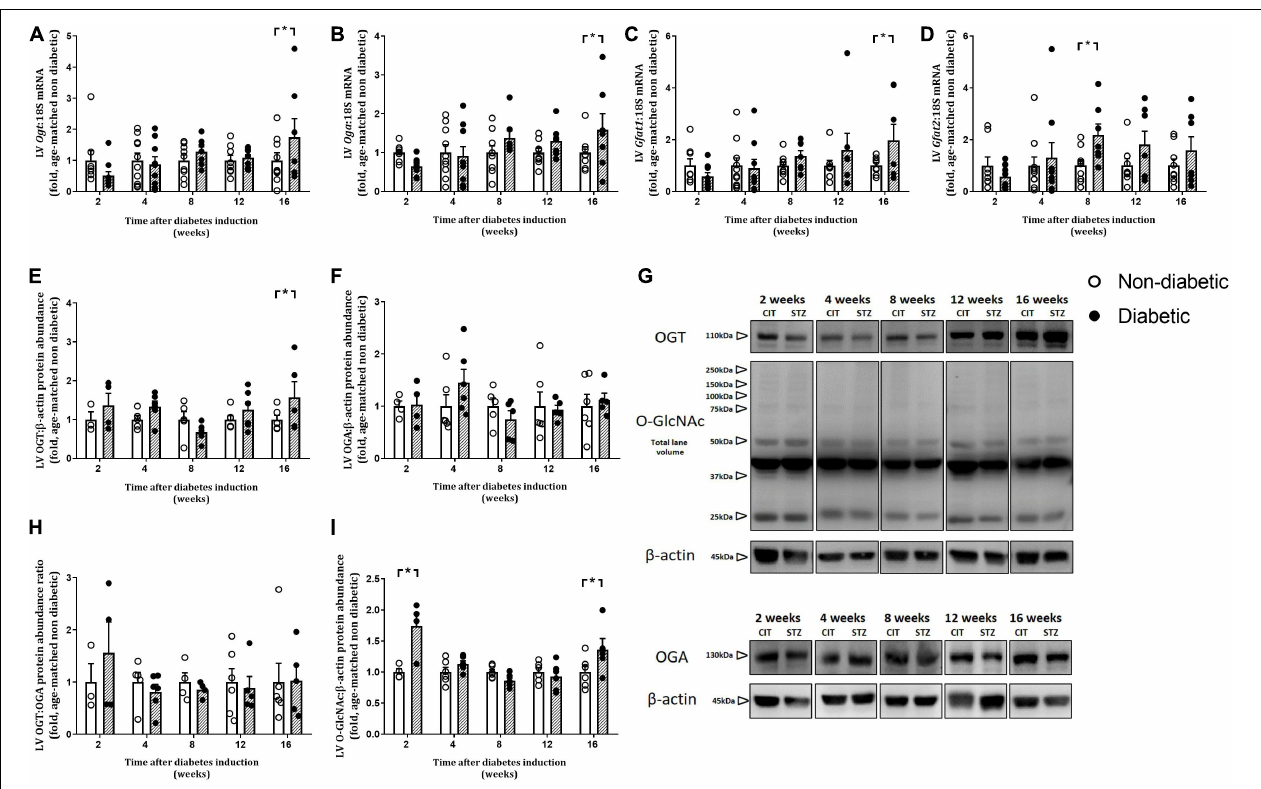
FIGURE 8 | Progressive changes in LV O-GlcNAcylation and its regulating enzymes. Gene expression of O-GlcNAc transferase ( Ogt : adds O-GlcNAc) (A) and O-GlcNAcase ( Oga : removes O-GlcNAc) (B) and the rate limiting enzymes of the HBP ( Gfat1 and Gfat2 , involved in O-GlcNAcylation) (C,D) involved in O-GlcNAcylation were increased with diabetes. LV protein abundance of OGT (E,G) , OGA (F,G) , OGT:OGA protein abundance ratio (H) , and total LV O-GlcNAcylated proteins (I,G) were measured in the heart at endpoint (using the CTD110.6 antibody for O-GlcNAc), and normalized to β -actin. Note the multiple bands in the O-GlcNAc blot including multiple faint high molecular weight bands. Data are presented as mean ± SEM. * P < 0.05 vs age-matched non-diabetic mice (two-way ANOVA with Benjamini and Hochberg post hoc test). O-GlcNAc/OGT western blots: n = 3–6/group; gene expression: n = 7–10/group (refer to Supplementary Figure S1 ). For all raw uncut western blots refer to Supplementary Presentation